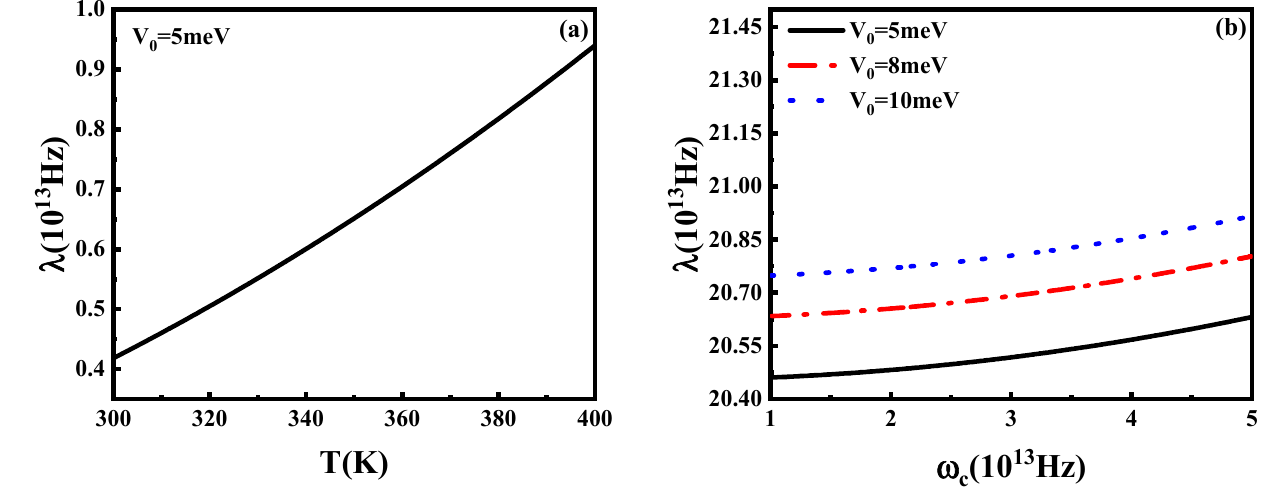
Figure 11. Vibrational frequency λ versus ( a ) temperature T and ( b ) magnetic field’s cyclotron frequency ω c .